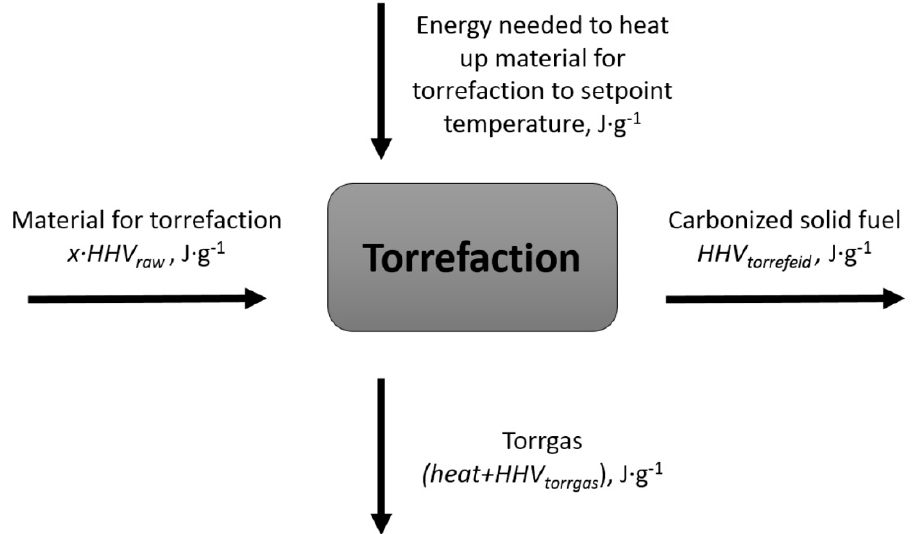
Figure 3. Energy balance of torrefaction to produce CSF (energy/mass).